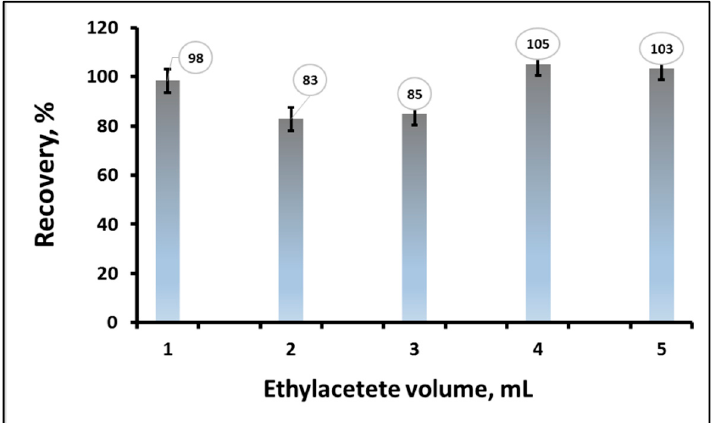
Figure 3. Effect of the eluent volume on the desorption of carbaryl from A100 Al-based MOFs ( n = 3).